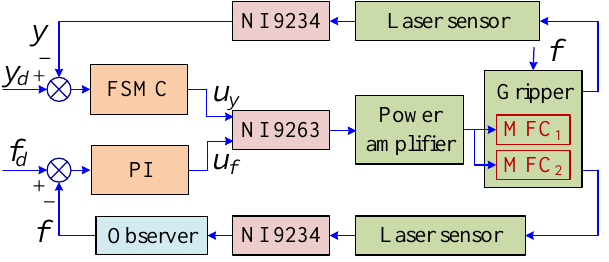
Figure 5. Schematic diagram of the hybrid position/force control scheme.